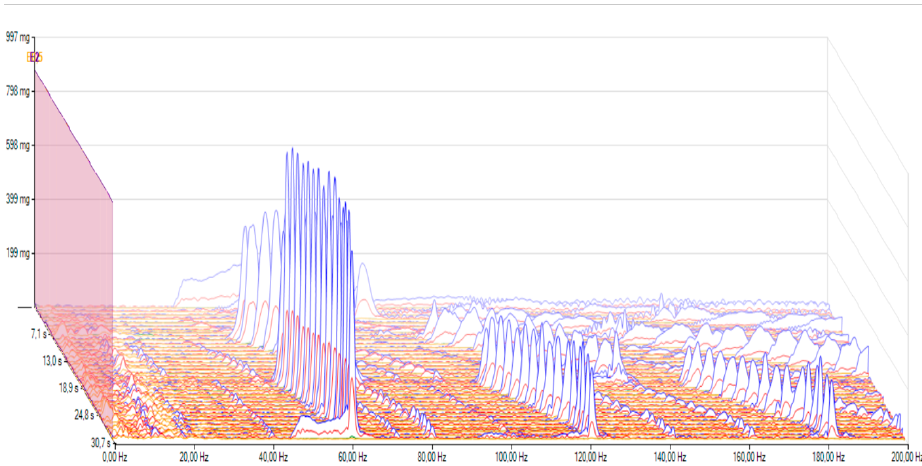
Figure 11. Vibrations in the frequency domain before the oil change, 0–70 km/h.